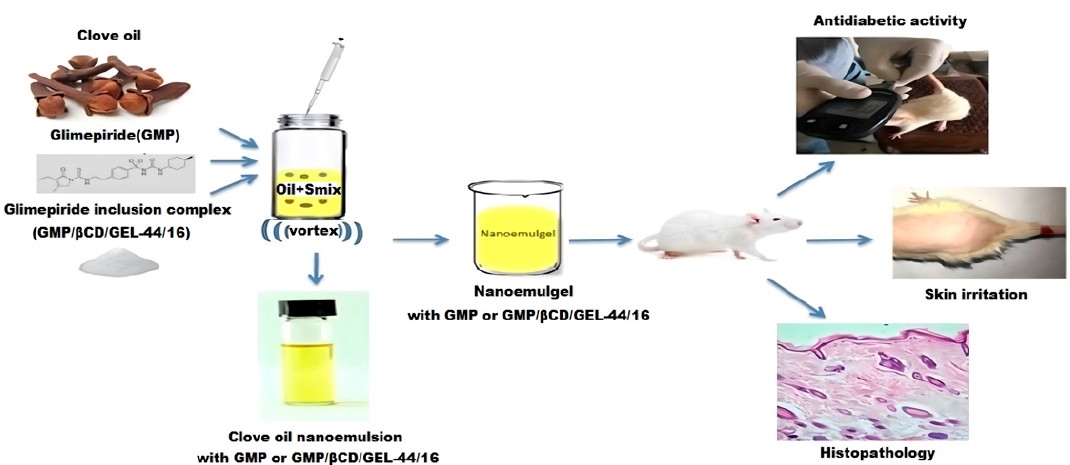
Figure 5. Schematic diagram of the preparation of the NE and its hypoglycemic effect, skin irritation, and in vivo antidiabetic evaluation [129]. Reproduced with permission from Fizza Abdul Razzaq, Cells; published by MDPI, 2021.